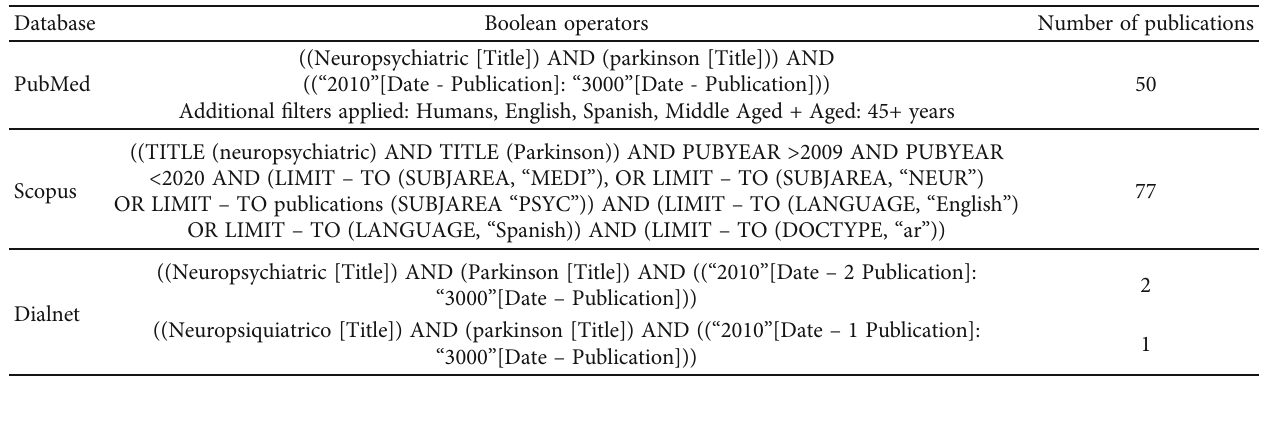
Table 3: Boolean operators and citations identi fi ed.